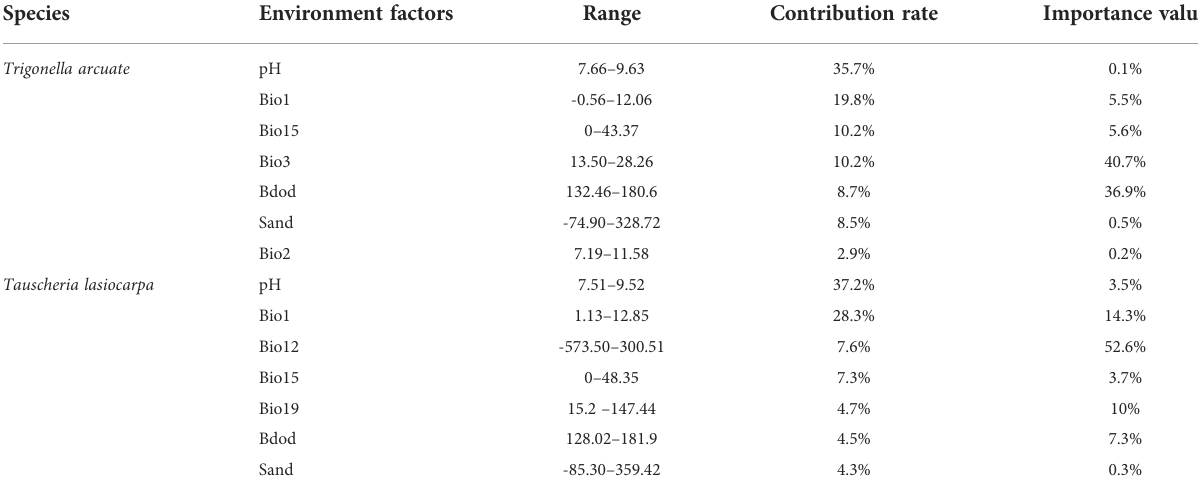
TABLE 4 Contribution of environmental factors to the distribution of ephemeral plants in cold deserts.